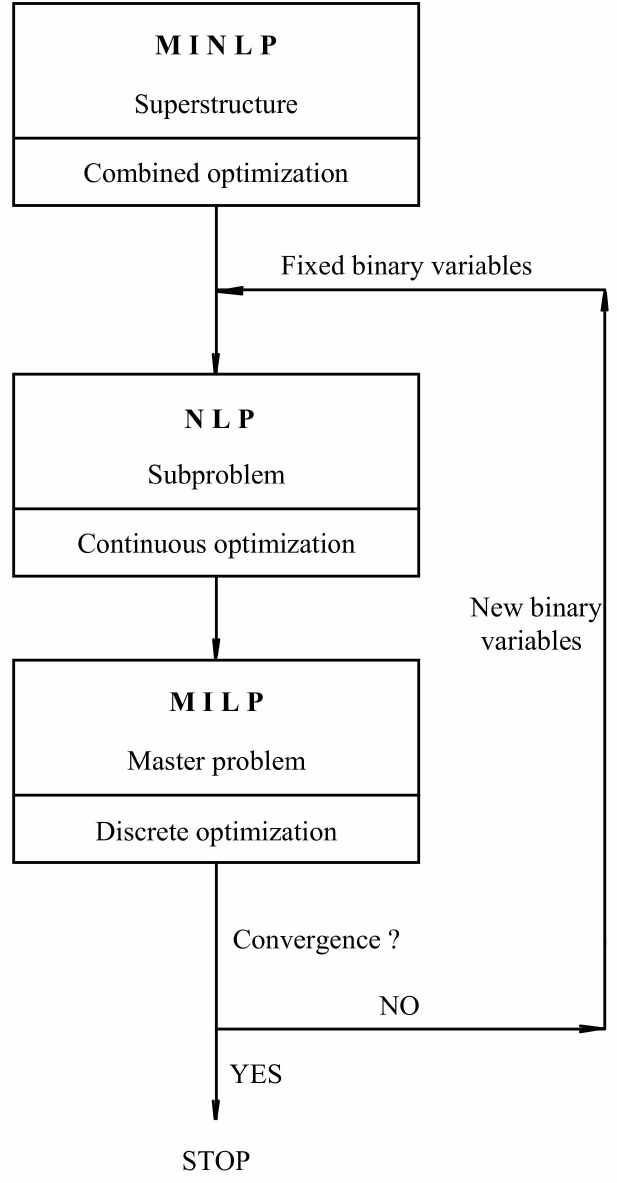
Figure 2. Steps of the Outer-Approximation/Equality-Relaxation